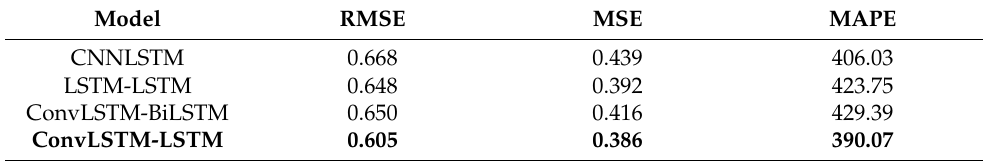
Table 5. Comparison of the evaluation metrics on the univariate UCI household electricity